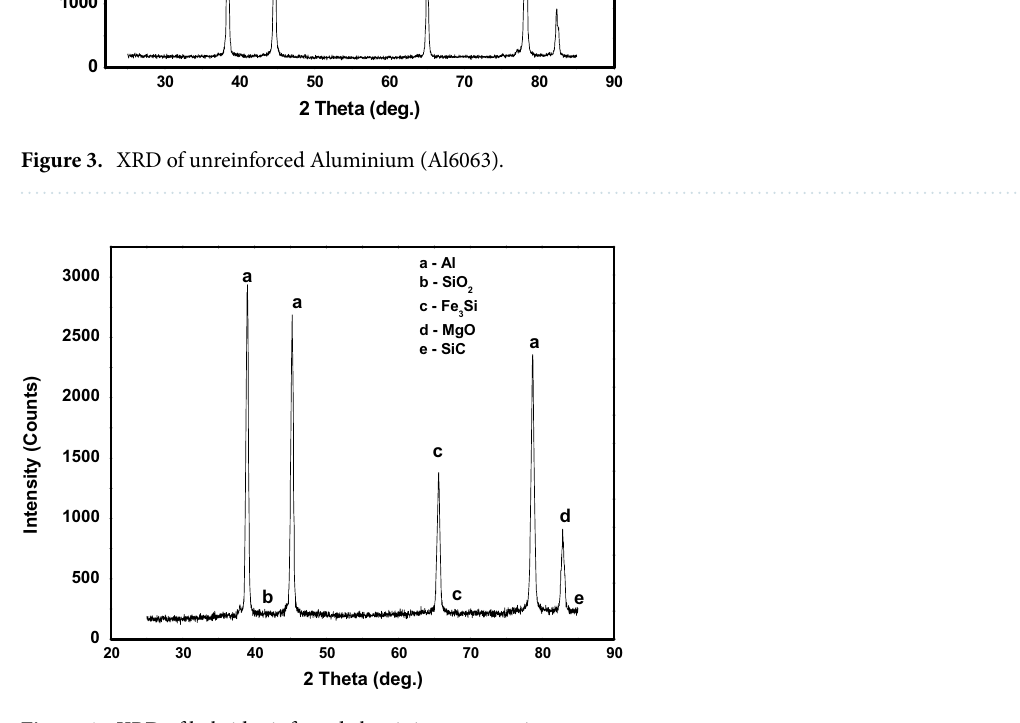
Figure 4. XRD of hybrid reinforced aluminium